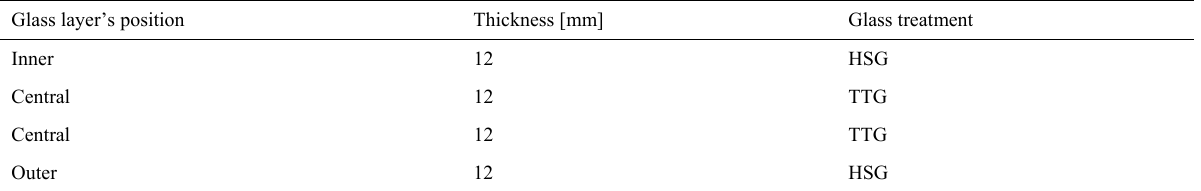
Table 1: Composition of the vertical laminated glass